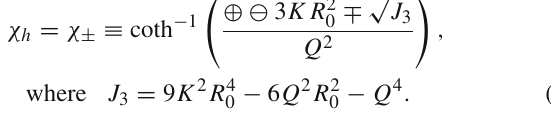
Fig. 3 Plot of metric function − 8 π R 2 hole type solution (blue): K = 1, Q = 1, R 0 = 1. (ii) dS-type